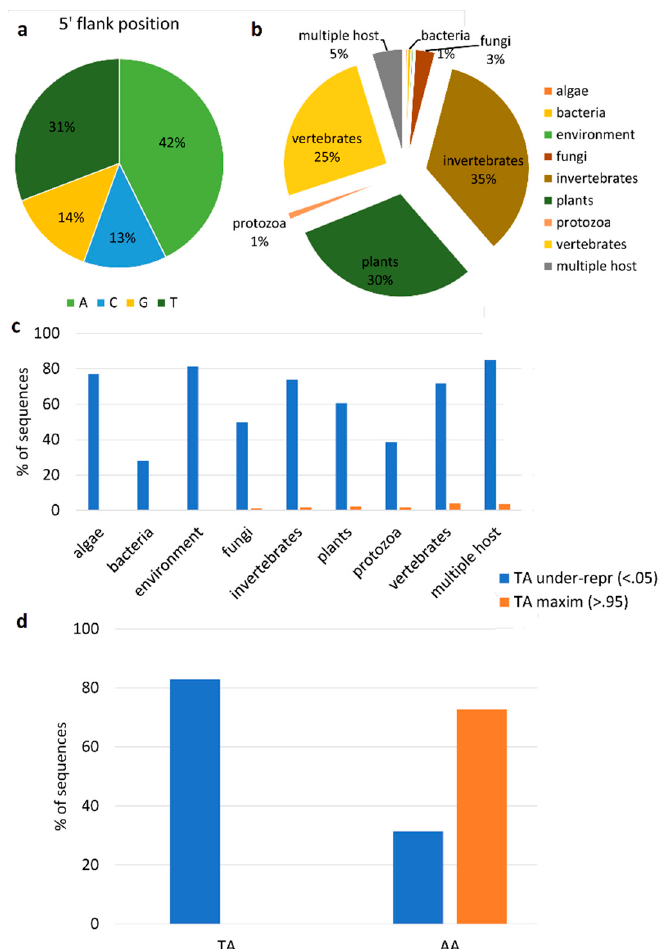
Figure 4. Analysis of virus editing. ( a ). Distribution of the flanking base of ADAR-compatible SNPs. ( b ). Host distribution of the 3872 viral genomes used as a training set. ( c ). Percentage of viral sequences ( N = 3872) showing statistically significant TA under-representation (<0.05) and maximization (>0.95), divided per host class. ( d ). Percentage of TA and AA under-representation (<0.05) and maximization (>0.95), measured on the coding sequences of the nearly complete viral genomes reported in this paper.